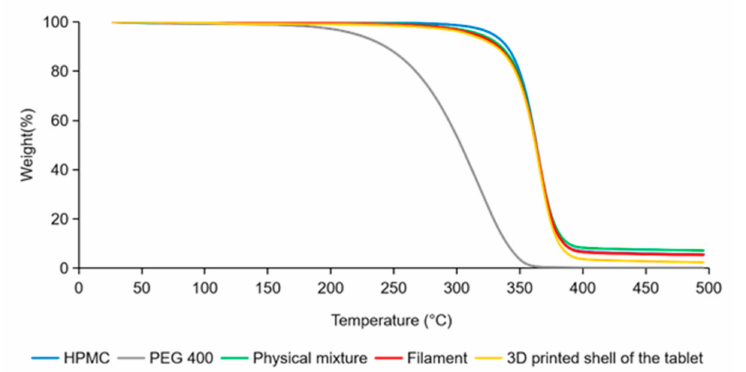
Figure 6. TGA results of HPMC, PEG 400, physical mixture, filament and 3D-printed shell of the tablet.